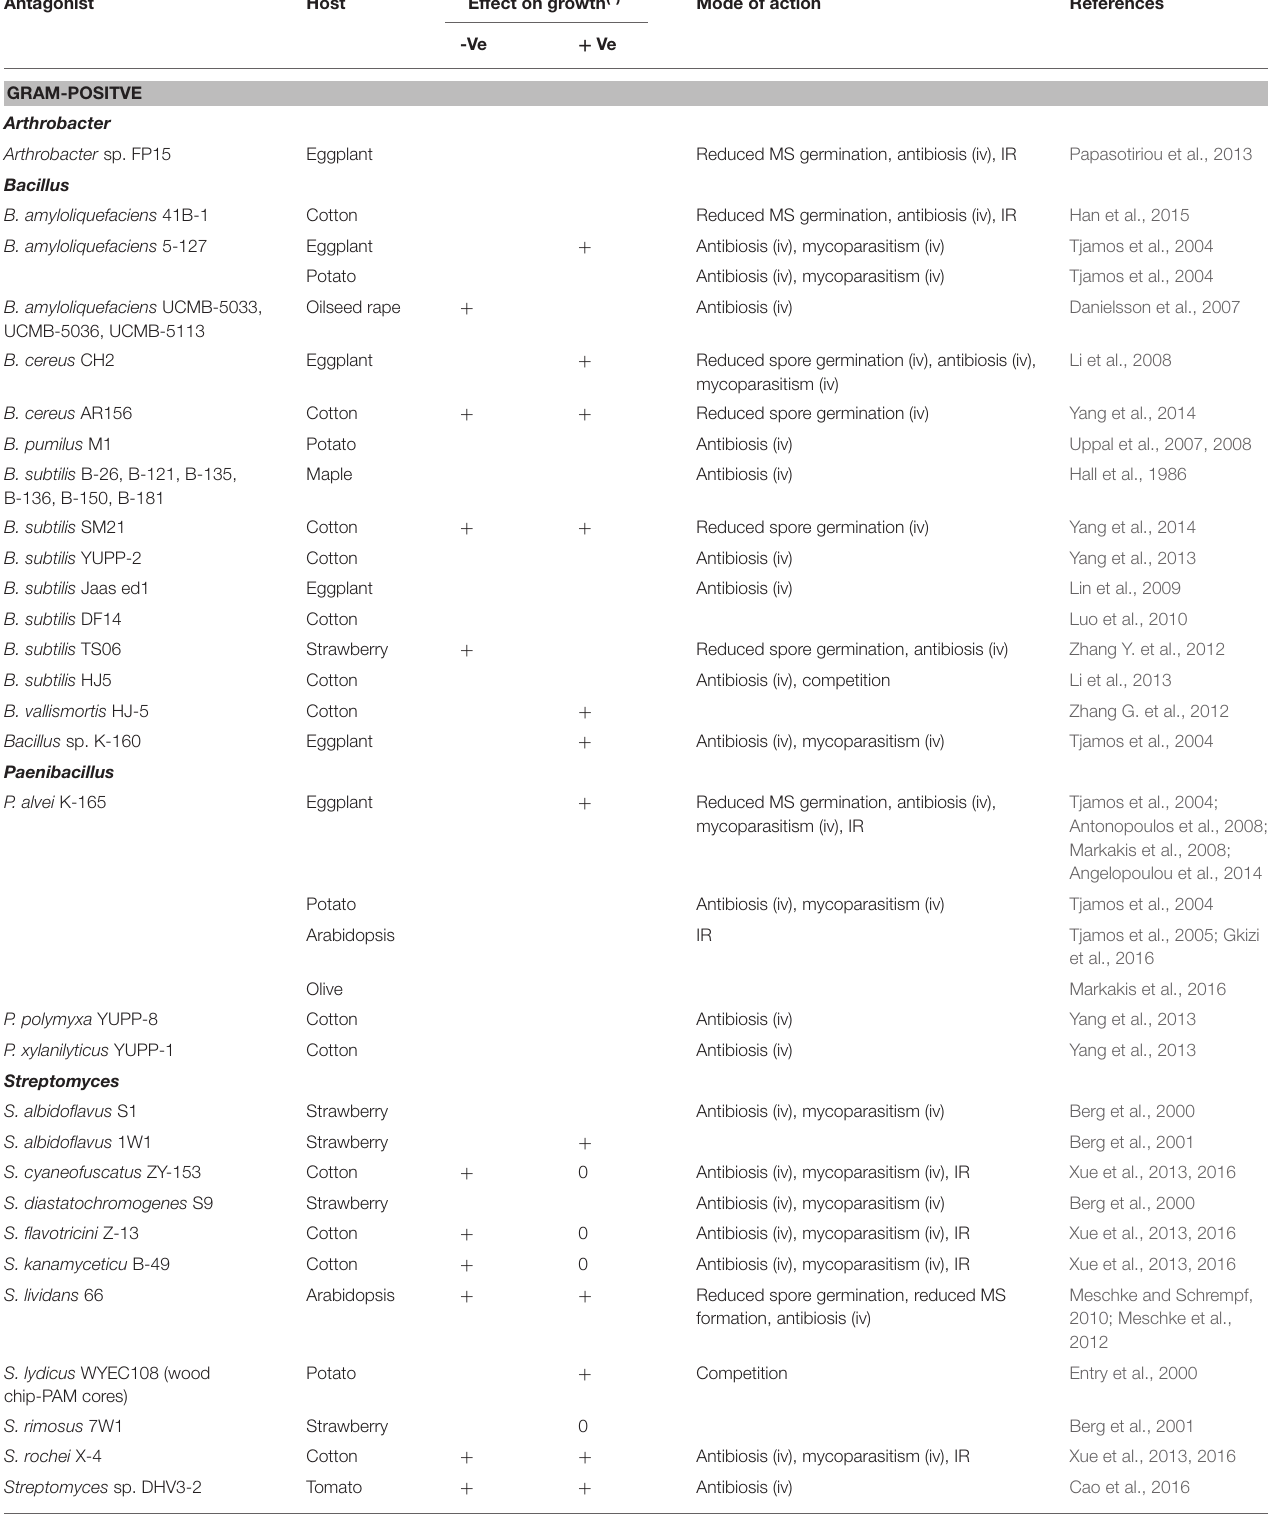
TABLE 2 | Bacterial isolates with biocontrol activity against Verticillium in different host plants.